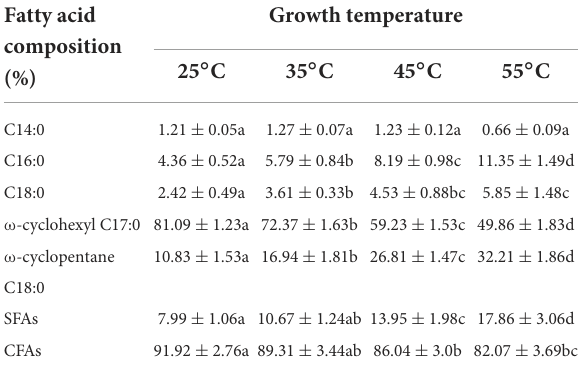
TABLE 1 The proportions of primary membrane fatty acid composition of A. acidoterrestris under different growth